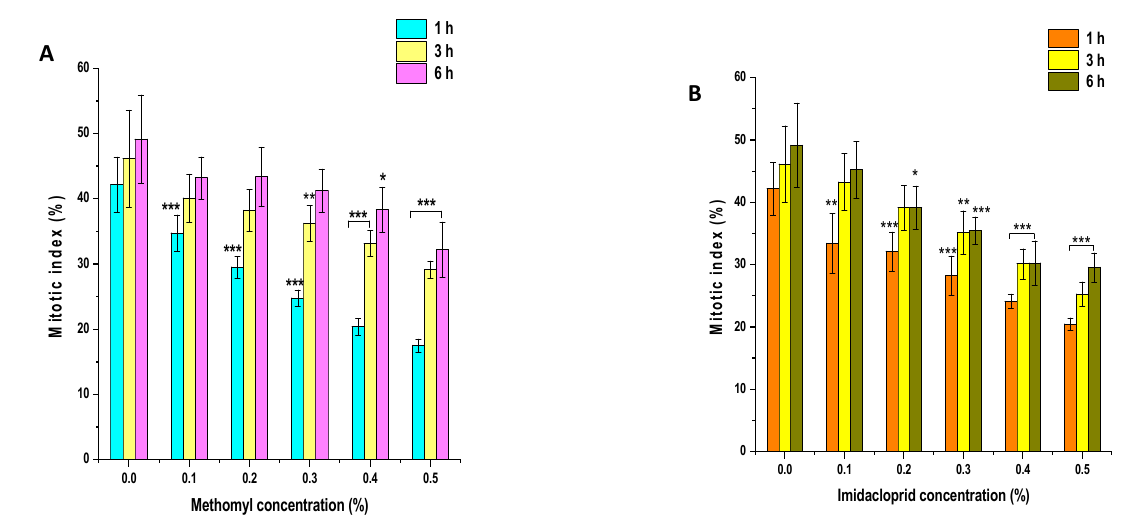
Figure 4. Effect of insecticide exposure on mitotic index in root tip cells of P. sativum seeds exposed to different concentration of ( A ) methomyl (ME) and ( B ) imidacloprid (IM) for 1, 3, and 6 h at 24 h after exposure. Data represent mean and SE. The experiment was repeated thrice. * p < 0.05; ** p < 0.01 and *** p < 0.001 compared to control at respective time interval.